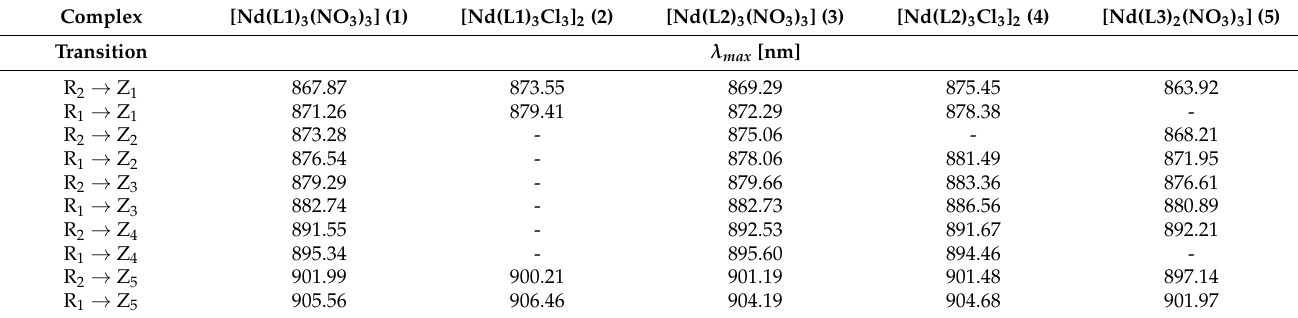
Table 1. A summary of λ max values of 1 – 5 of transition lines corresponding to the 4 F 3/2 → 4 I 9/2 transi- tion.